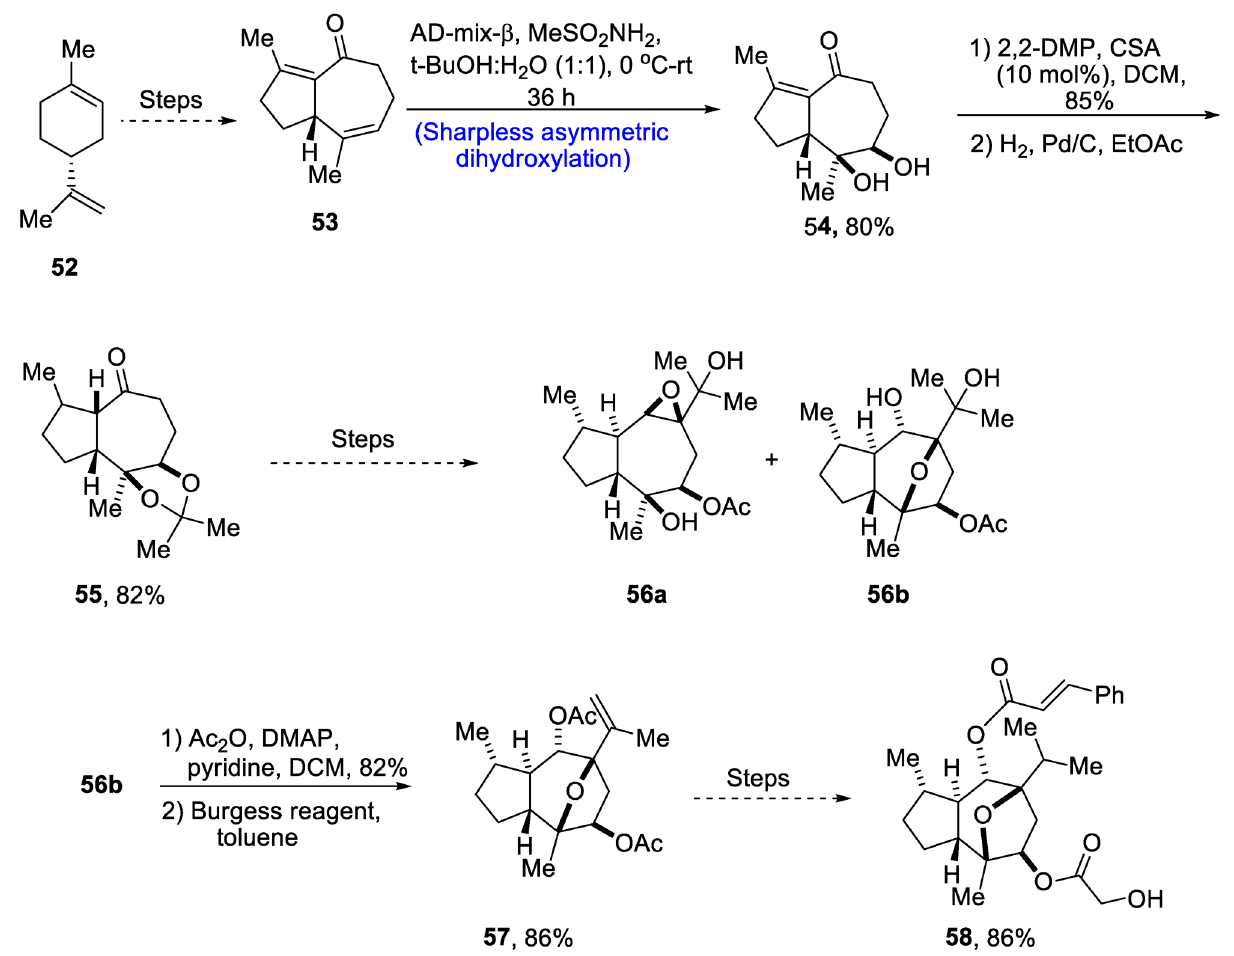
Scheme 9. Synthesis of 4-epi-englerin A 58